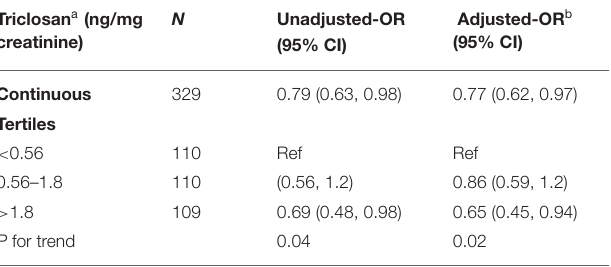
TABLE 3 | The association between triclosan and infertility using a multivariable logistic regression